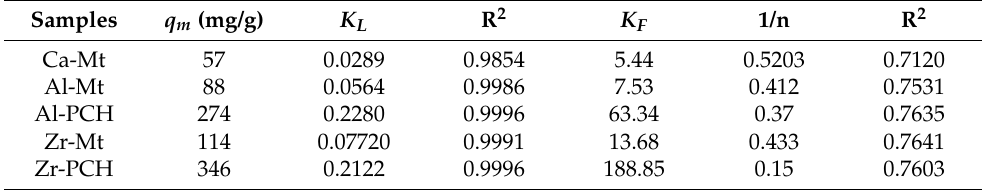
Table 3. Estimated Langmuir and Freundlich parameters for the studied materials.